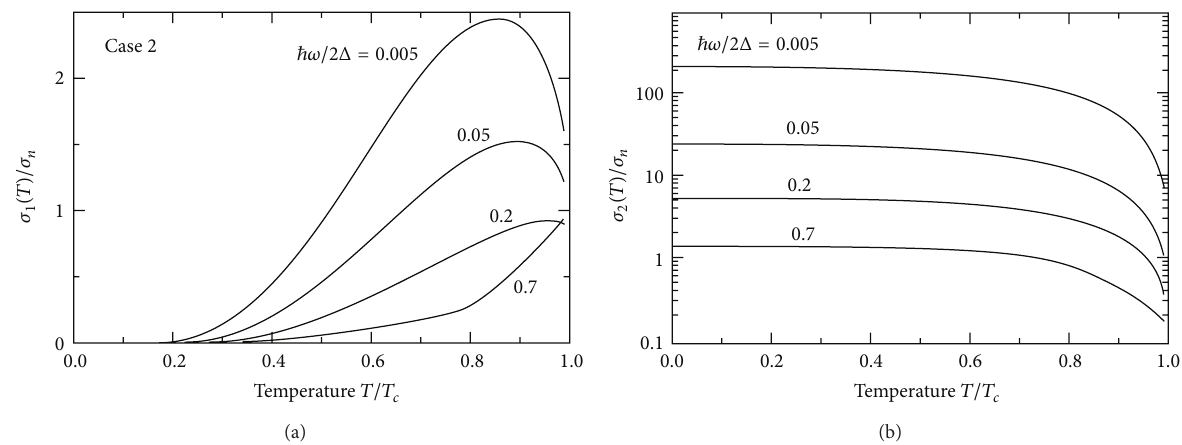
Figure 6: Temperature dependence of the conductivity of a superconductor at different frequencies 𝜔 with respect to the gap frequency 2Δ/ℏ . (a) For low frequencies the conductivity first rises as 𝑇 decreases below 𝑇 𝑐 and exhibits a pronounced maximum before it drops to zero for 𝑇 → 0 . This so-called coherence peak becomes smaller as the frequency increases; eventually 𝜎 The imaginary part 𝜎 2 (𝜔)/𝜎 𝑛 increases continuously with decreasing temperature. In the static limit, it resembles the development of the superconducting gap Δ(𝑇)